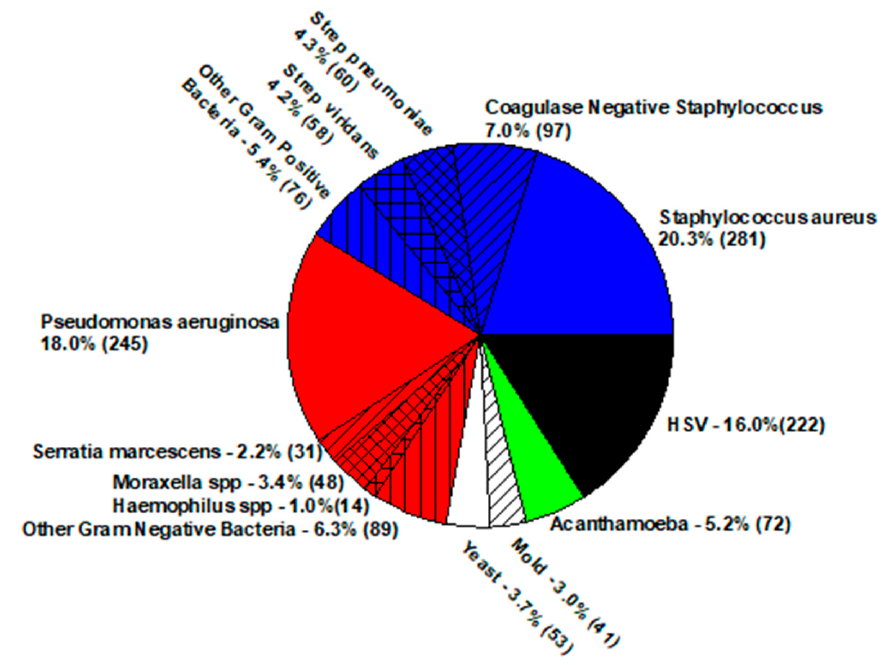
Figure 2. Distribution of infectious keratitis pathogens.